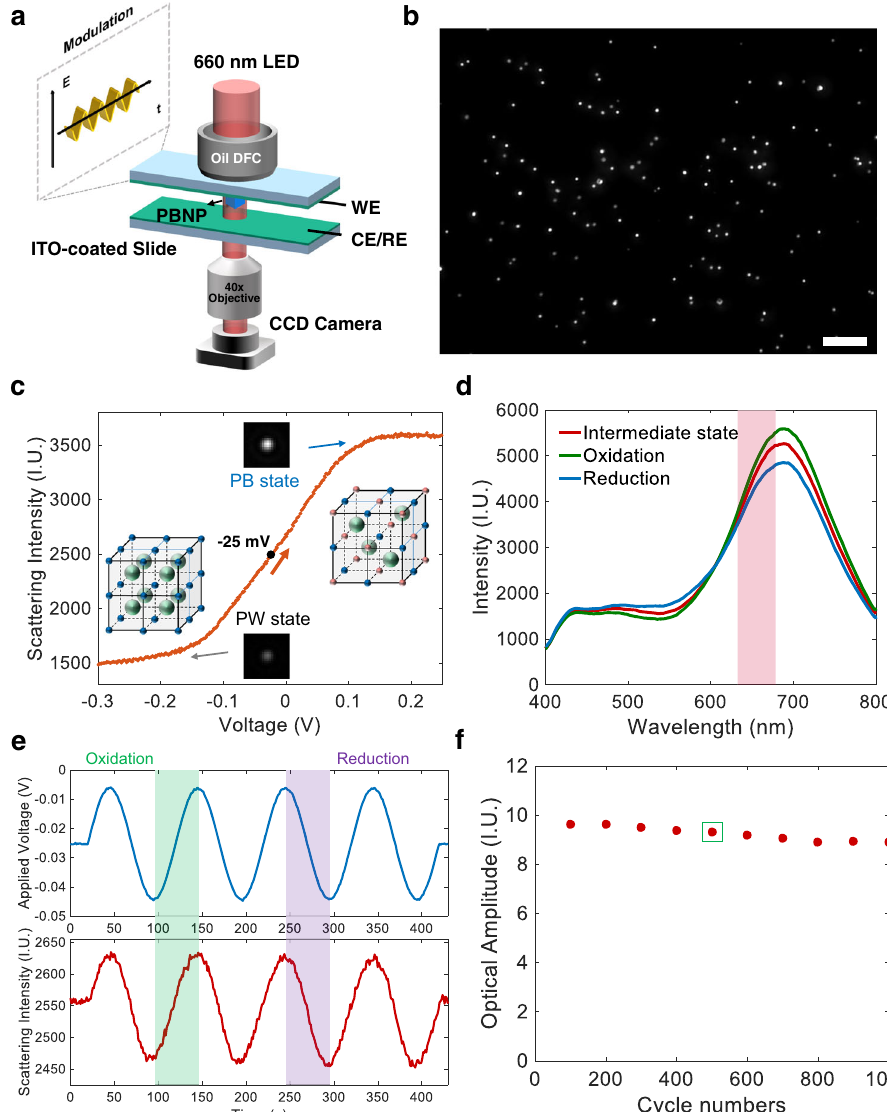
Fig. 1 The dark- fi eld device for extracting scattering intensity of single PBNPs during potential modulation. a Schematic illustration of monochromatic DFM coupled with electrochemical cell to measure the oEIS of single PBNPs. b Representative dark- fi eld image of several tens of PBNPs. Scale bar: 10 μ m. c Clear dependence of the scattering intensity of single PBNPs with the electrode potential was observed; the scattering intensity of the oxidized state (PB) was 2.3 times higher than that of the reduced state (PW). Scan rate was 5 mV/s. Crystal structures of PB and PW are also shown; blue sphere: Fe 2 + , red sphere: Fe 3 + , green sphere: K + . d Representative dark- fi eld scattering spectra of single PBNPs at three different voltages: 5 mV (green), − 25 mV (red), and − 55 mV (blue). The red area is the wavelength range that we conduct dark- fi led imaging. e Scattering intensity of single PBNPs as a function of sinusoidal potential modulation (frequency, 0.01 Hz; amplitude, 20 mV; offset, − 25 mV). The green and purple area represent the oxidation and reduction process respectively. f Cyclability of single PBNPs for 1000 consecutive cycles during potential modulations (1 Hz); the average optical amplitude is extracted every 100 cycles. The detailed calculated process about the 400 – 500th cycles (green box inside) is provided in Supplementary Section 4. Source data are provided as a Source Data fi